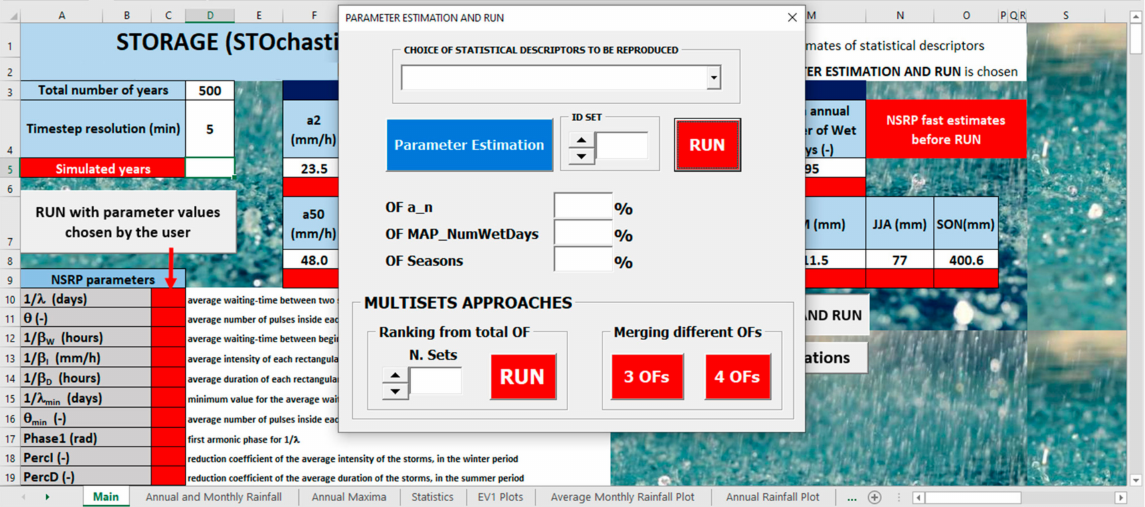
Figure 5. Userform where a user can carry out calibration and select several run